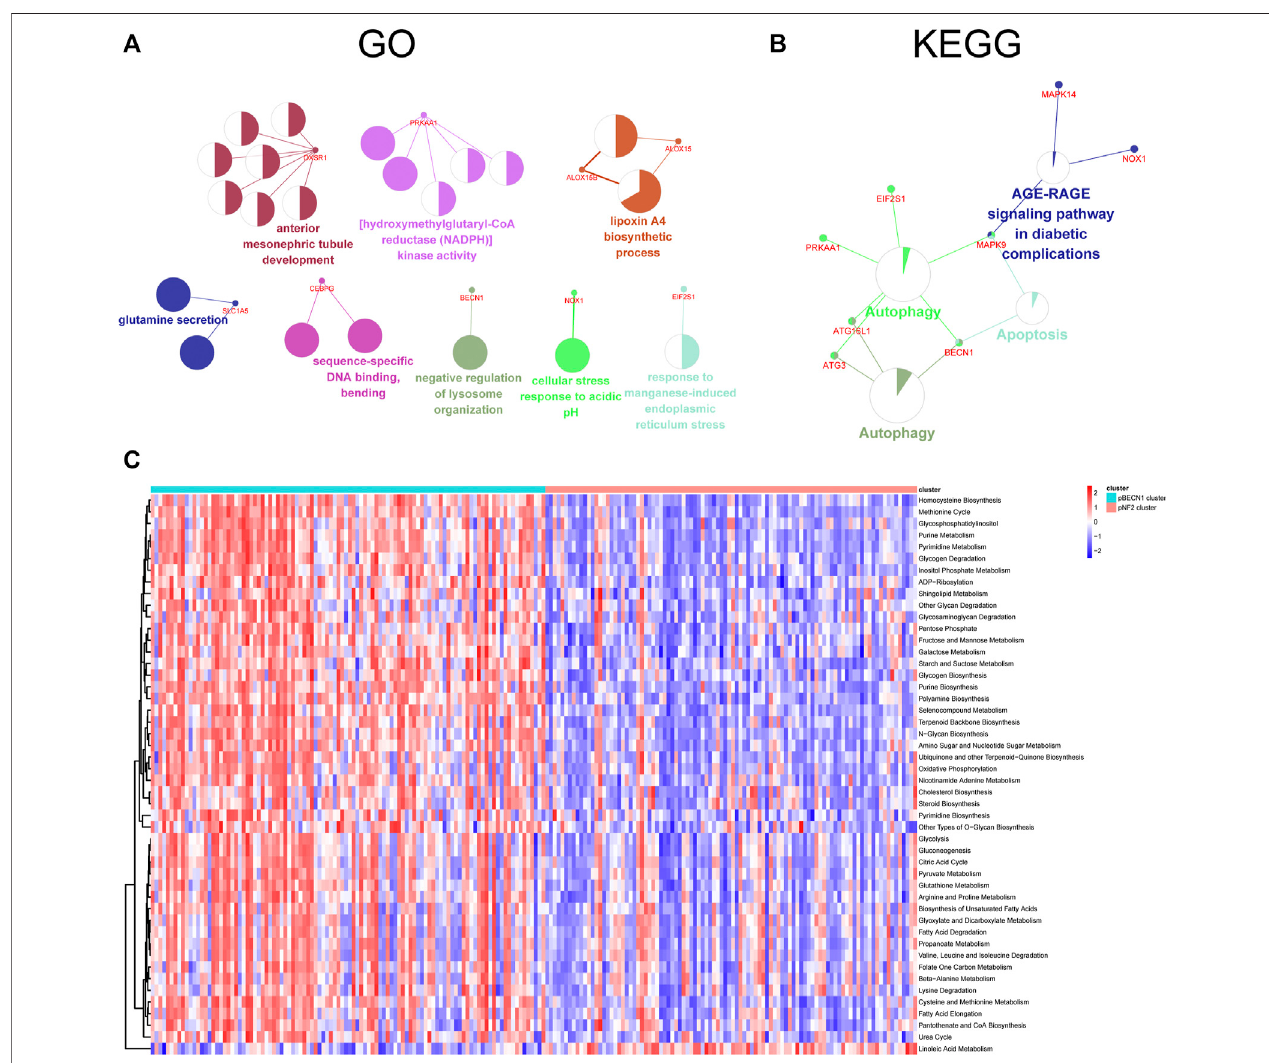
FIGURE6| Functionalenrichmentanalysisofthetop10correlatedgenesandthepBECN1clusterandthepNF2cluster. (A,B) GOandKEGGenrichmentanalysis of the top 10 correlated genes in each cluster using the ClueGO plugin of Cytoscape software. (C) Gene Set Variation Analysis (GSVA) in terms of metabolic signaling signatures showing functional differences between the pBECN1 cluster and the pNF2 cluster. Terms with adjusted p < 0.05 were selected. The color bar showed the GSVA score in each sample.